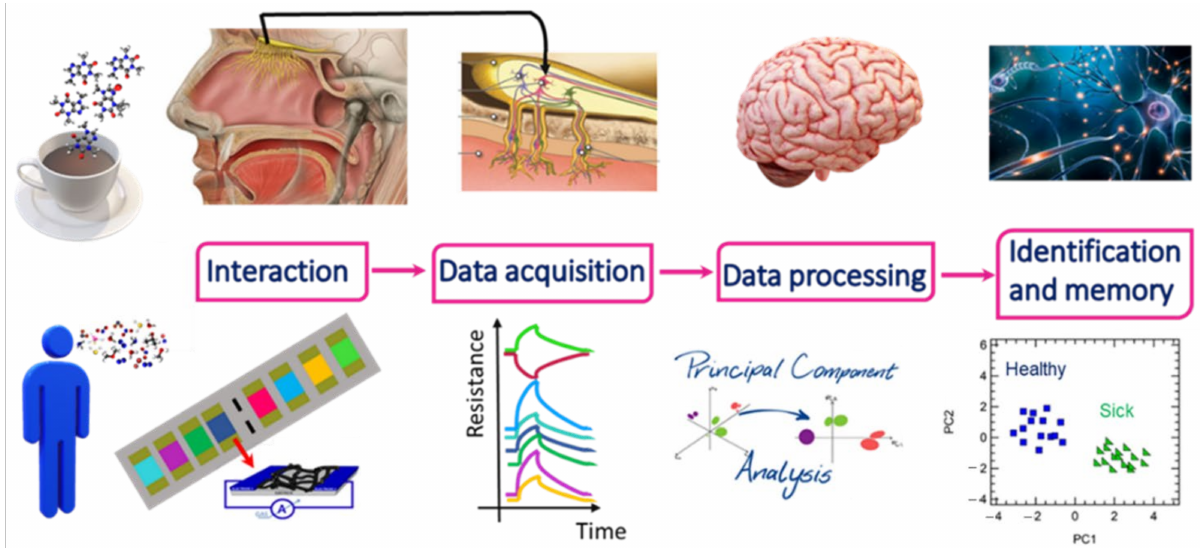
Figure 2. Schematic comparison of the working principle of the human nose and electronic